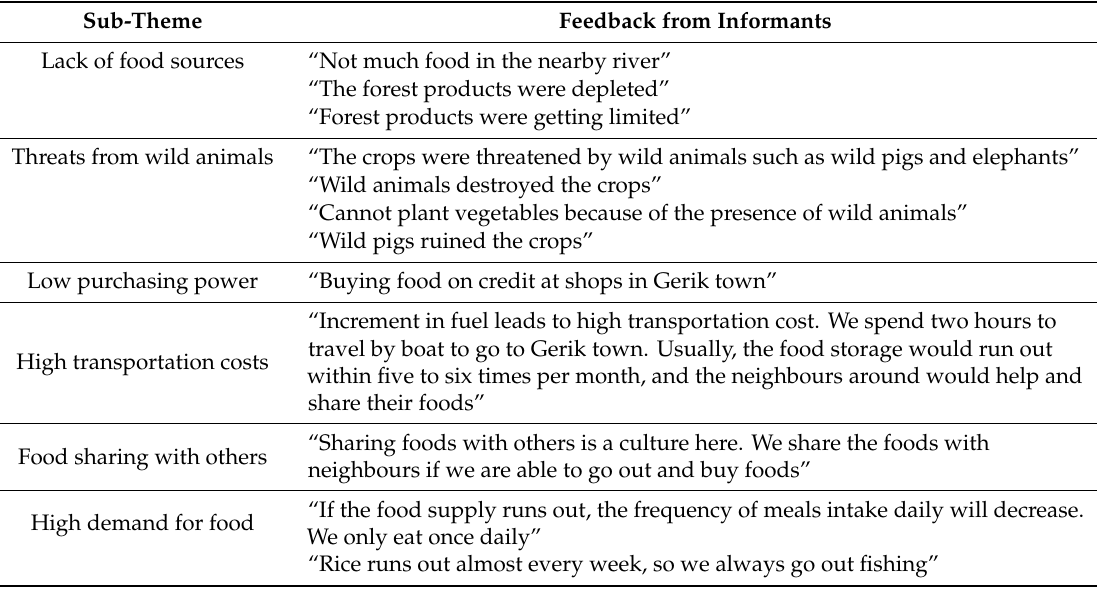
Table 3. Sub-themes of barriers in obtaining foods and feedback from